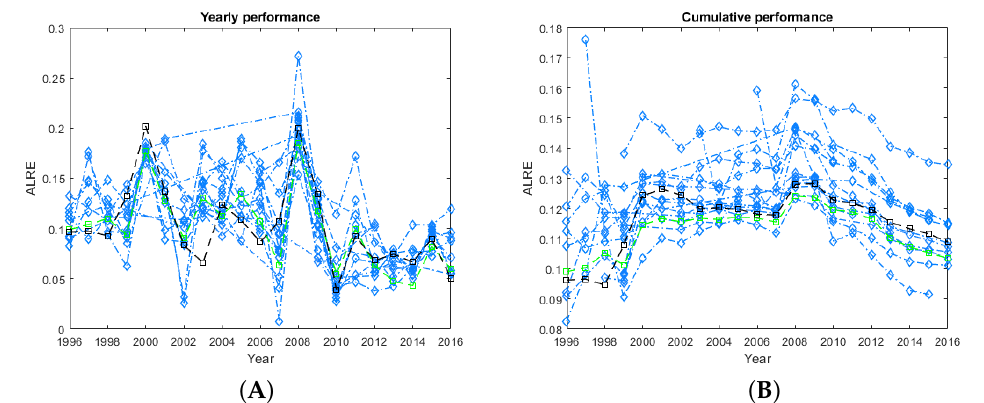
Figure 4. The average ALRE scores over all questions, for each year between 1996 and 2016, for all experts who answered at least one question from the 229 questions also answered by the Australian Treasury, shown as ( A ) yearly performance, and ( B ) as cumulative performance. Each line corresponds to a single expert, with the black line corresponding to the Australian Treasury forecasts. The green line corresponds to the nominal